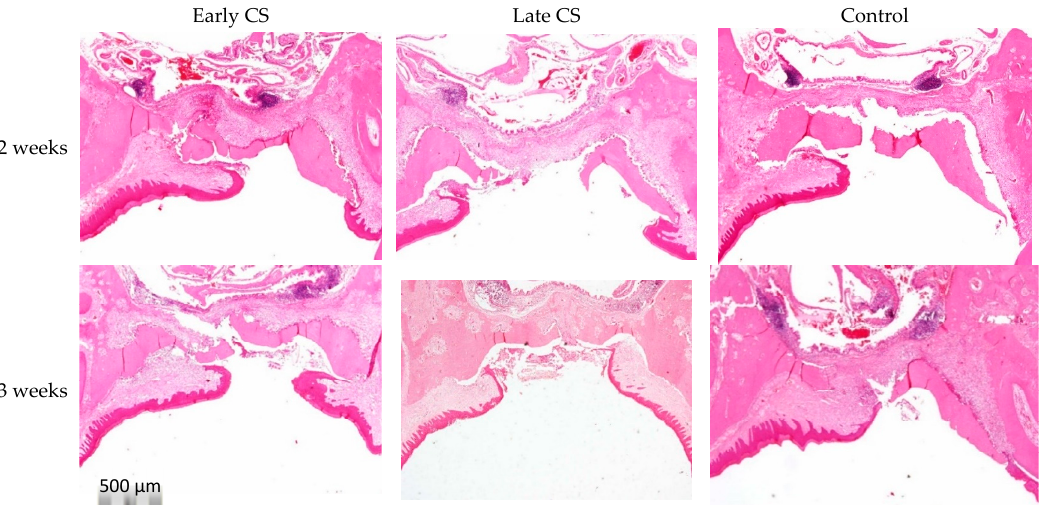
Figure 4. Representative photomicrographs of the wound region at two and three weeks. At two weeks, there was more inflammation compared to the third week. Mean scores are detailed in Table 2. Full epithelization was not completed by the third week (Hematoxylin and eosin stain, original magnification ×40).